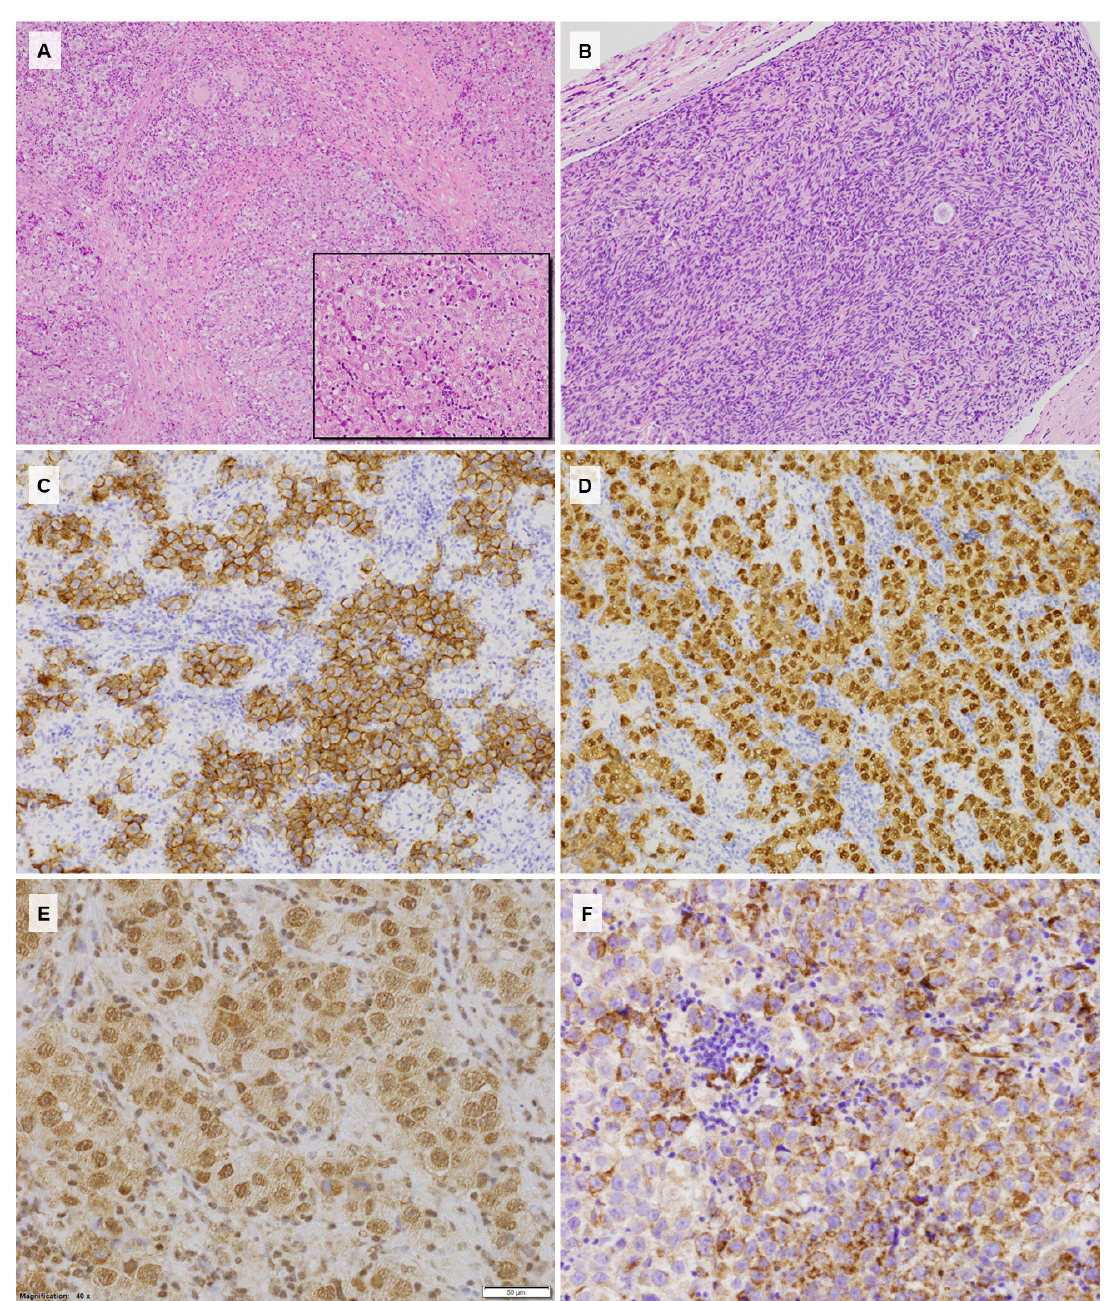
Figure 1. ( A ) Histology of dysgerminoma with stromal fibrous bands and small reactive granulomas (HE, 100×); ( B ) histology of the streak gonad contralateral to the tumor showing the ovarian stroma with a single primordial follicle (HE, 200×); ( C ) strong CD117 expression with membranous enhancement within the neoplastic cells (CD117, 200×); ( D ) Oct3/4 immunoreactivity in the dysgerminoma cells (Oct3/4, 200×); ( E ) Gli1 expression showing strong nuclear and low cytoplasmic reactions (Gli1, 400×); ( F ) SHH cytoplasmic immunostaining within the neoplastic component and negative stromal lymphocytes (SHH, 400×).